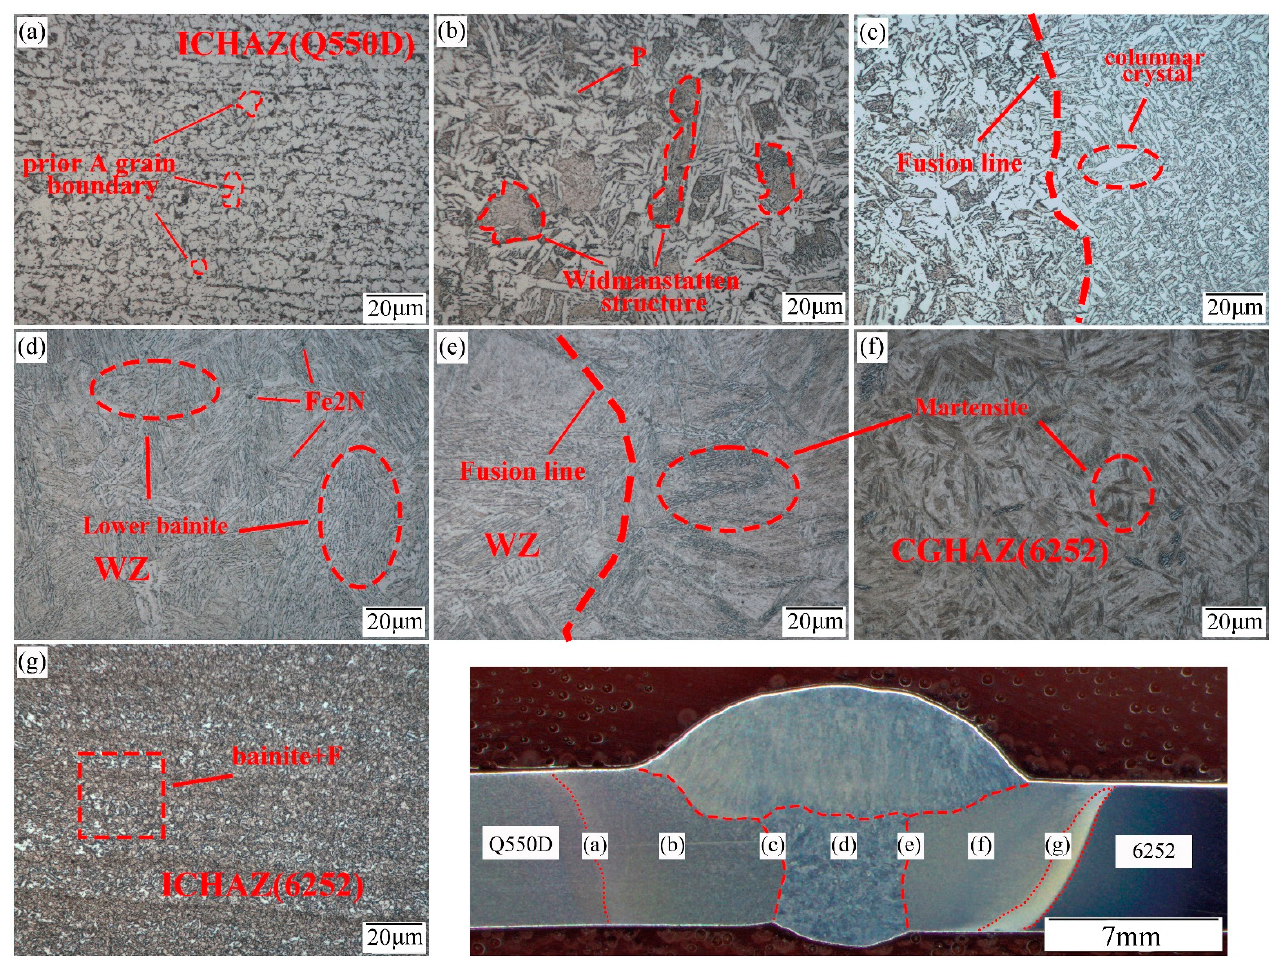
Figure 4. Microstructure of the dissimilar welded joint (ER140S-G): ( a ) intercritical HAZ (Q550D), ( b ) coarse-grained HAZ (Q550D), ( c ) fusion zone (Q550D), ( d ) weld zone, ( e ) fusion zone (6252), ( f ) coarse-grained HAZ (6252), and ( g ) intercritical zone (6252).